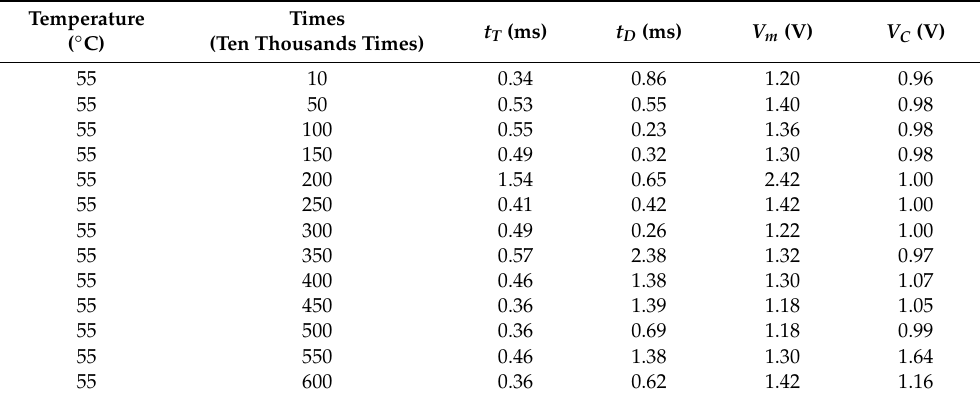
Table 4. Experimental results of relay at 55 ◦